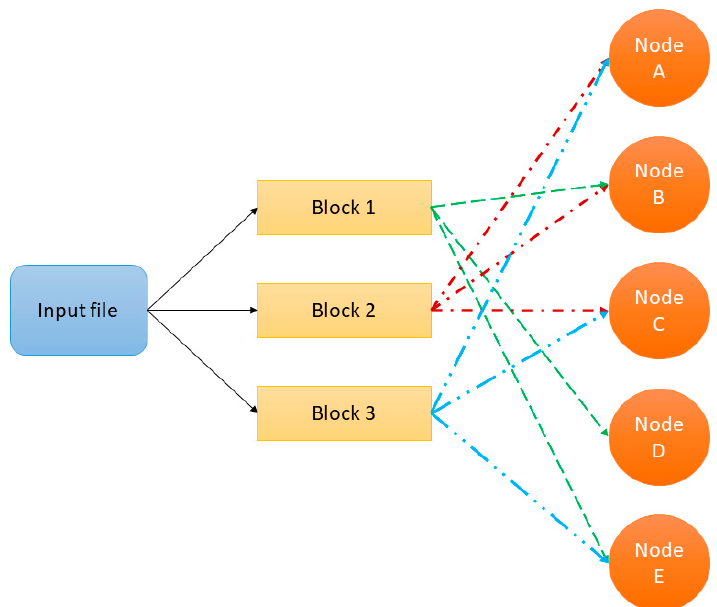
Figure 4. Hadoop Distributed File System as a Component of Distributed Processing.